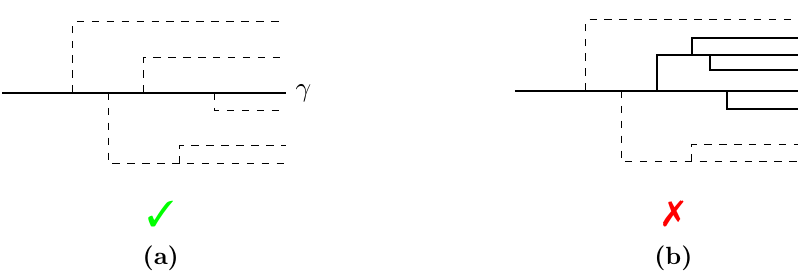
Figure 2. Schematic representations of soft drop isolation, where solid (dashed) lines indicate jet constituents kept (dropped) by soft drop declustering. (a) A photon that passes soft drop isolation, because its parent jet fails soft drop, leaving just a singlet photon (as determined by a particle identi(cid:12)cation scheme). (b) A photon that fails soft drop isolation, because its parent jet has hard substructure that passes soft